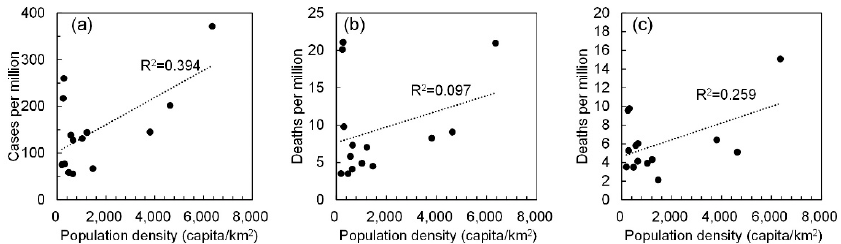
Figure 2. Correlation between population density and number of confirmed positive cases and fatality. The number of ( a ) positive cases, confirmed deaths ( b ) including and ( c ) excluding those caused by nosocomial infection.